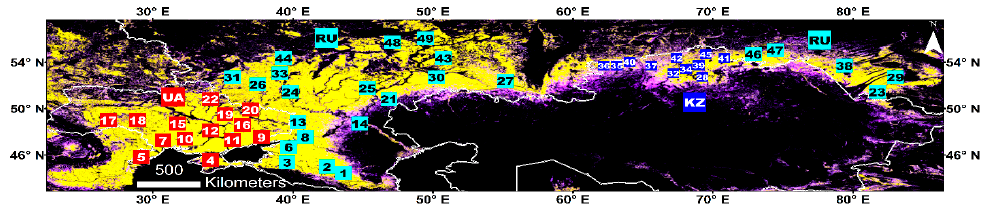
Figure 2. Study region cropland stability map superimposed with the 49 specific AMSR-E pixels selected for this study. The AMSR-E pixels are numbered by latitude starting from the most southern site. Name for each site is their closest large settlement (cf. Table 3). Red squares are in Ukraine, cyan squares in Russia, and blue squares in Kazakhstan.